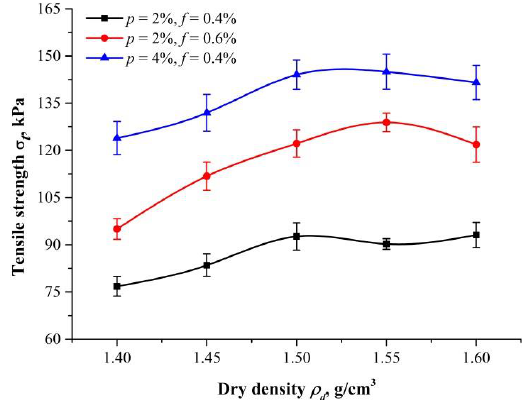
Figure 11. Tensile strength of specimens with different dry density ( t = 48 h, and the bars are standard deviations).